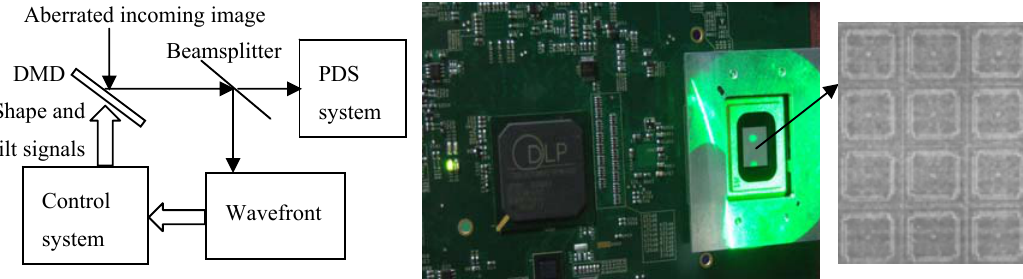
Figure 1. Using DMD to correct distorted wavefront in AO system